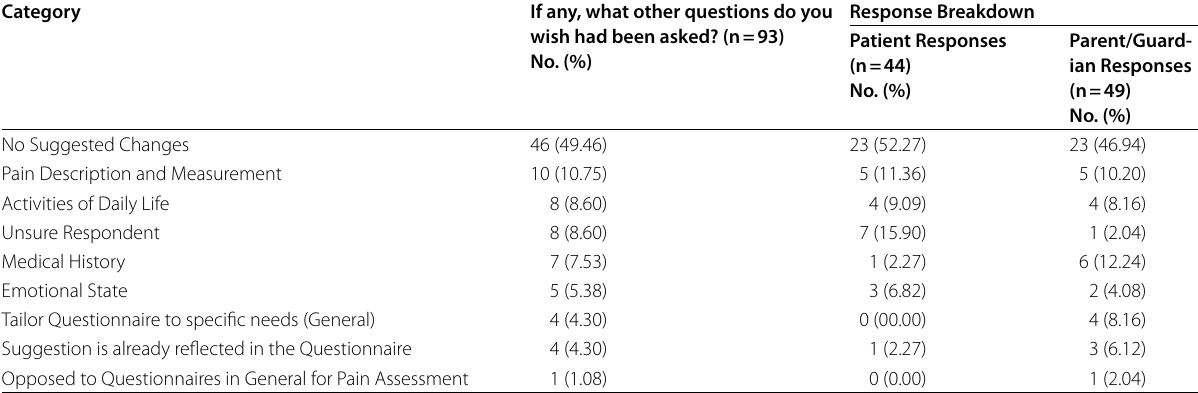
Table 4 *Distribution of Survey Comments on what to Add from the Questionnaire